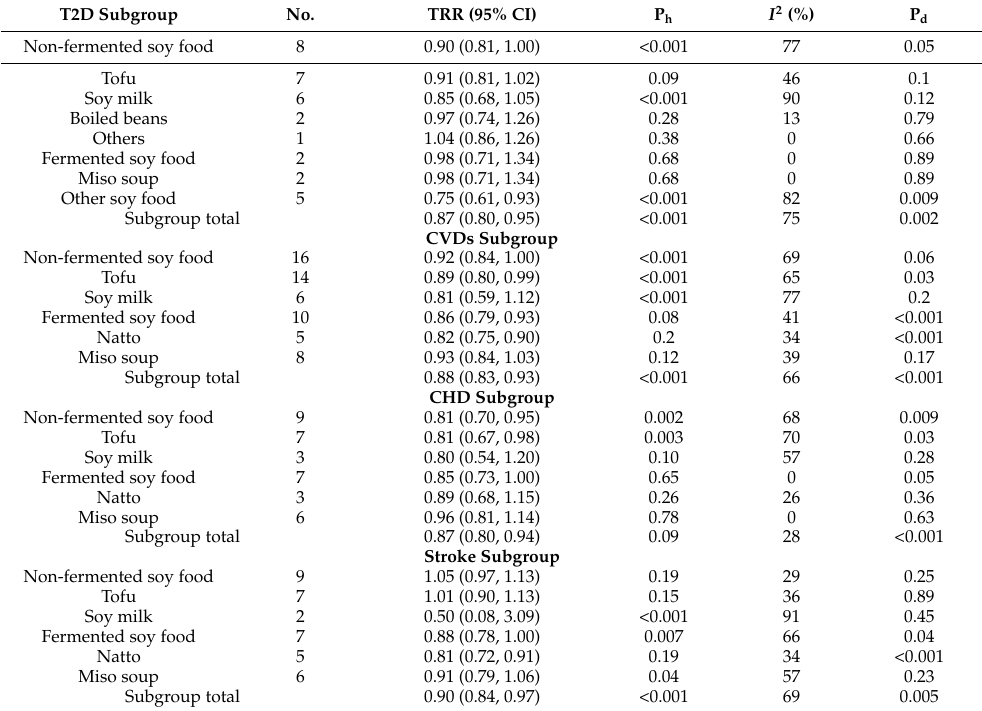
Table 2. Stratified analyses between soy foods intake and the risk of T2D and CVDs events. T2D